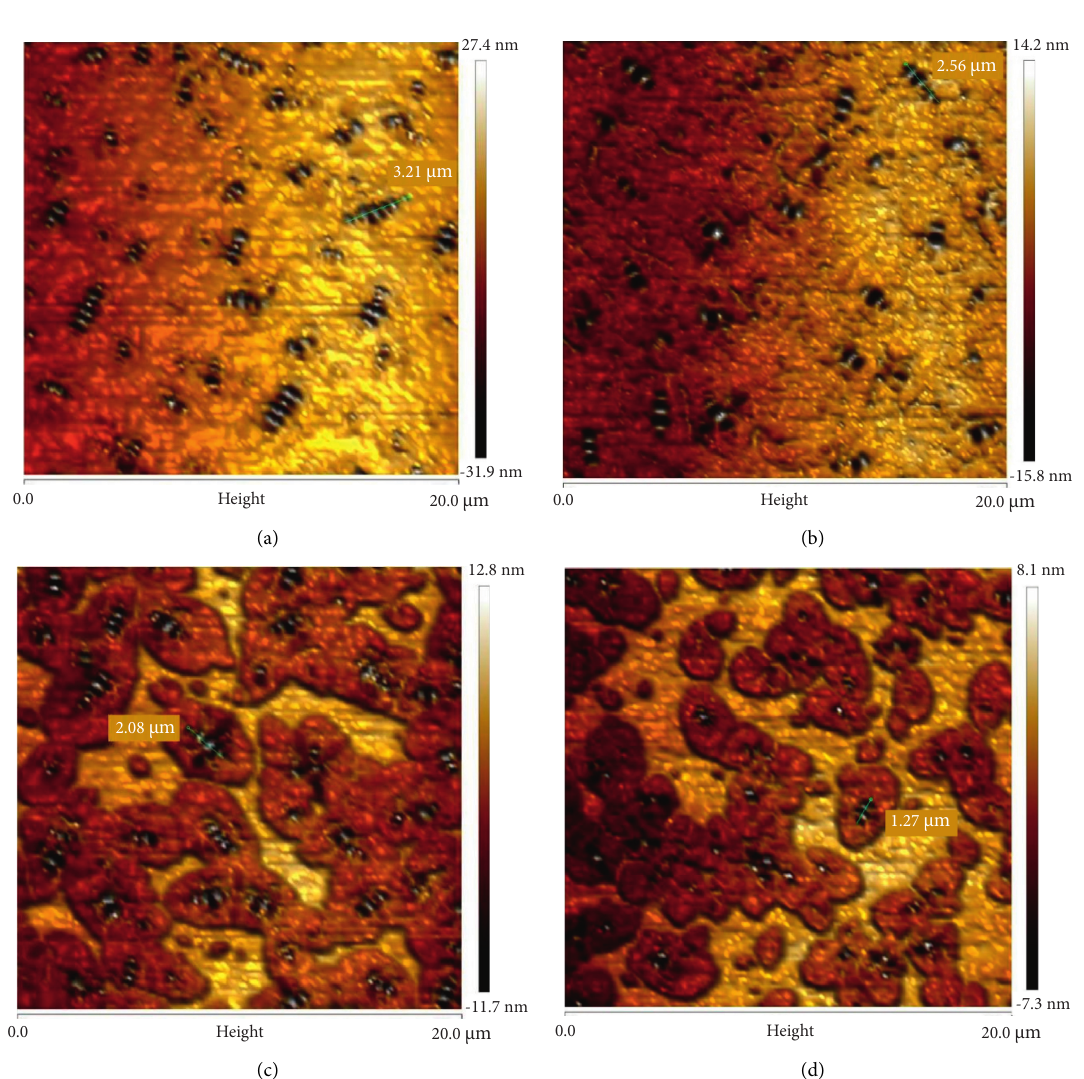
Figure 14: Phase images of WEOB-modified SBS asphalt, (a) 0%, (b) 2%, (c) 4%, and (d)